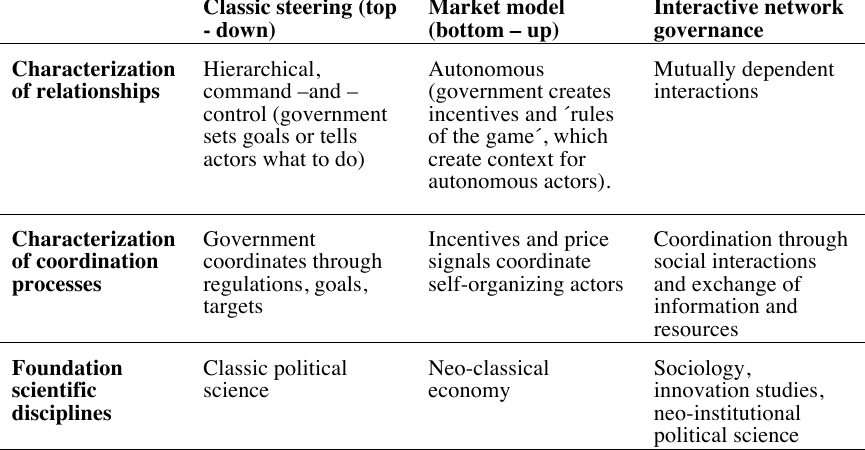
Table 2. The main features of the three different policy paradigms (De Bruijn et al., 1993: 22)